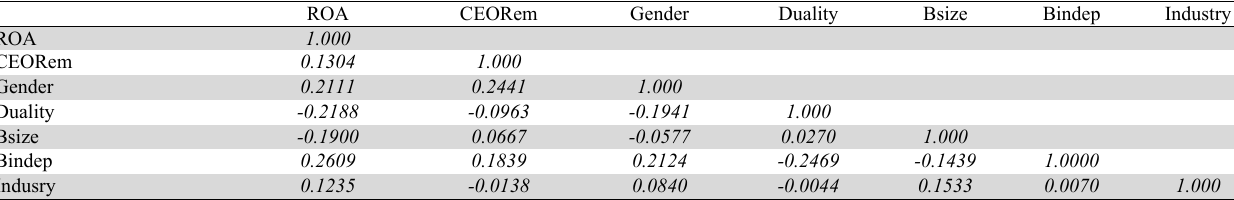
Correlation coefficients of variables related to the M2